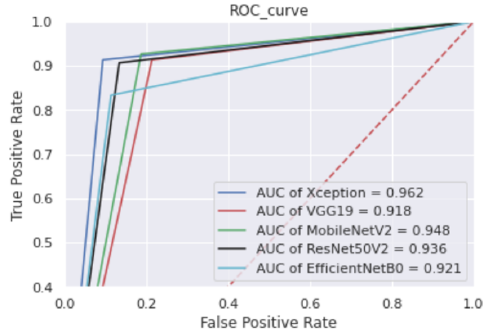
Figure 7. ROC curve of the models.